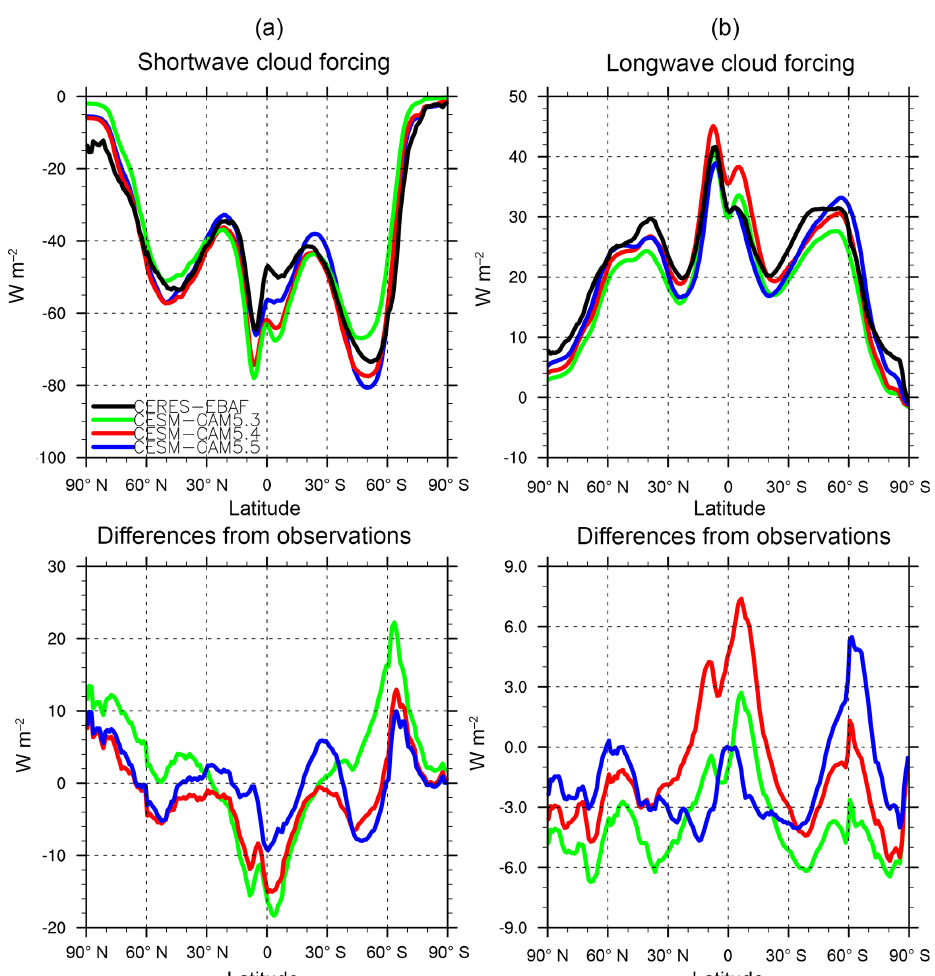
Figure 3. Zonal averages of the shortwave (a) and longwave (b) cloud forcing for model simulations and CERES-EBAF observations. Zonal average differences from CERES-EBAF observations displayed on the bottom